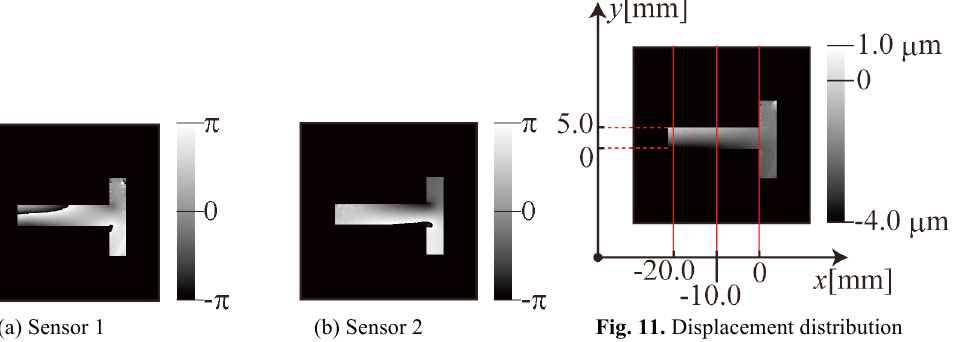
Fig. 11. Displacement distribution Fig. 10. Phase difference for the x -direction